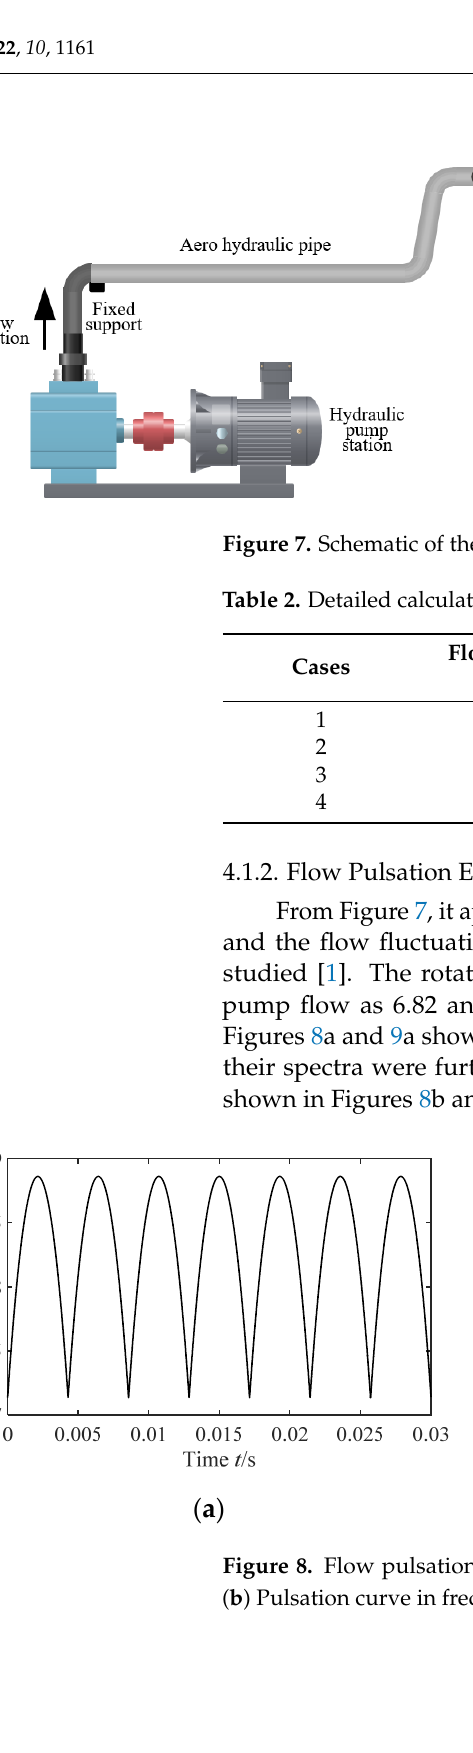
Figure 9. Flow pulsation excitation (flow velocity is 8 m/s). ( a ) Pulsation curve in time domain. ( b ) Pulsation curve in frequency domain. As shown in Figures 8 and 9, the time domain curves of the flow pulsation change periodically with time; from the spectrum diagram, it can be seen that there are efficiency spikes at the fundamental frequency and its multiple frequencies, which means that the periodic function of the flow pulsation can be superimposed with a series simple har- monic pulsations. The first four natural frequencies, as well as the corresponding ampli- tudes, of the flow pulsation are compared in Table 3. Table 3. Spectrum characteristics of flow pulsation. Flow Velocity (m/s)